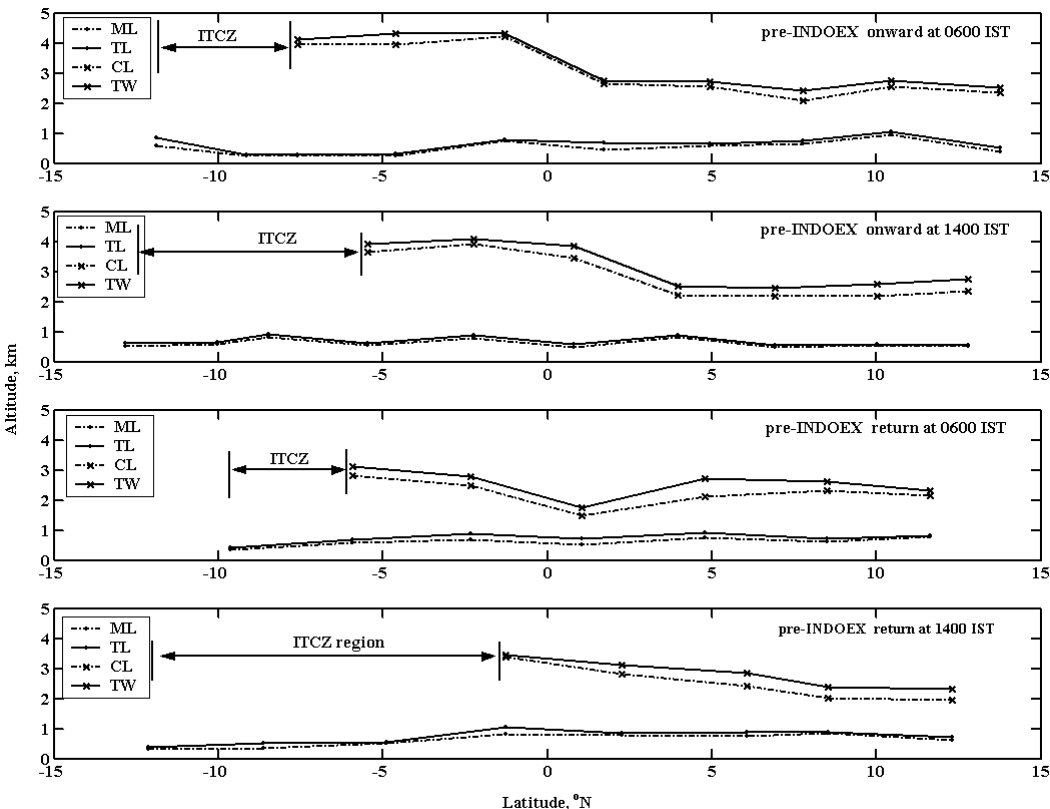
Fig. 4. Latitudinal variation of Mixed Layer (ML) height, Transition Layer (TL) height, Cloud layer (CL) and Trade Wind inversion (TW) heights during pre-INDOEX. The continuous and dotted lines joined with the dot symbol represent the TL height and ML height, respectively. The continuous and dotted lines joined with the cross symbol represent the TW height, and CL height